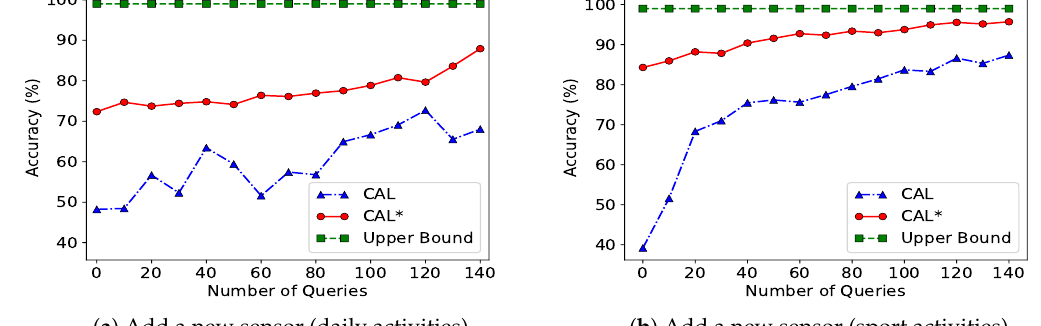
Figure 5. Performance of the collaborative active learning algorithm under a configuration change (adding a new sensor) scenario. Subfigure ( a ) shows results for the daily activities dataset, and subfigure ( b ) shows results for the sport activities dataset.